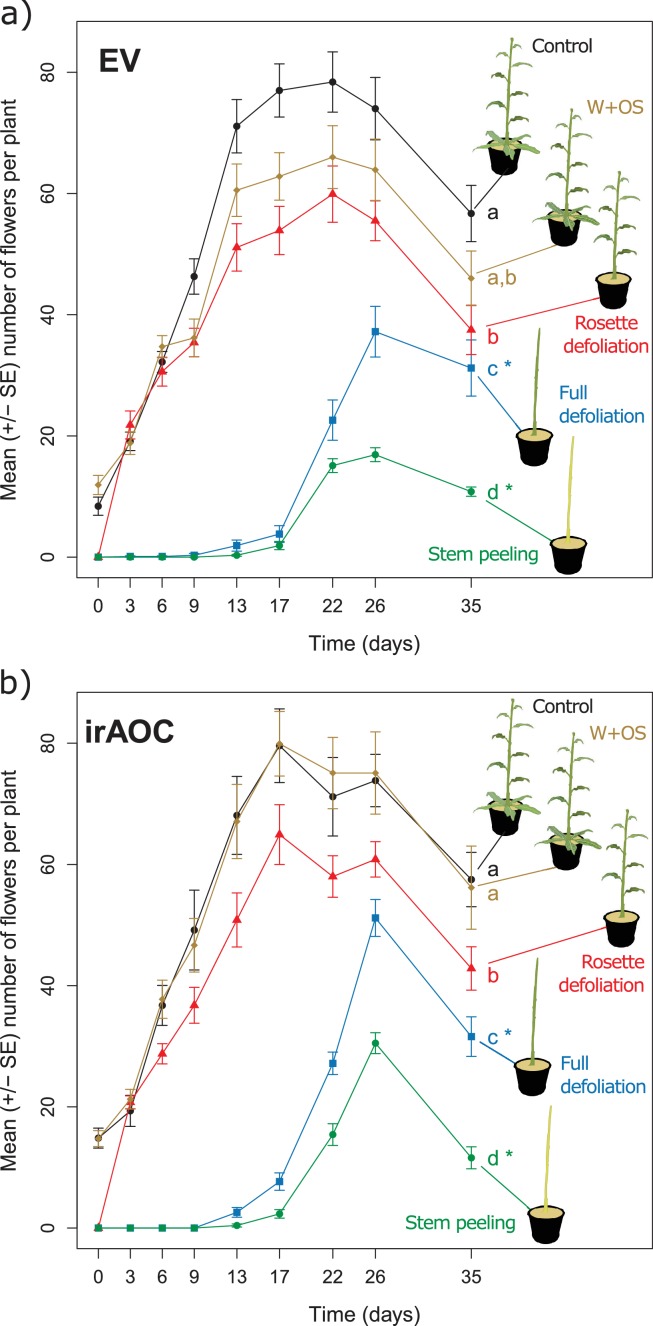
Simulated vertebrate attack strongly reduces plant flower production.Average (±SE) flower production of wild type (a) and jasmonate deficient irAOC plants (b) following different simulated herbivory treatments (n =10–12). Different letters indicate significant differences between treatments within genotypes (p<0.05). Asterisks indicate significant differences between genotypes within treatments (*p<0.05). W+OS: Wounding + application of Manduca sexta oral secretions.DOI:
http://dx.doi.org/10.7554/eLife.13720.01110.7554/eLife.13720.012Figure 2—source data 1.Fitness costs of induction and defoliation in the glasshouse.